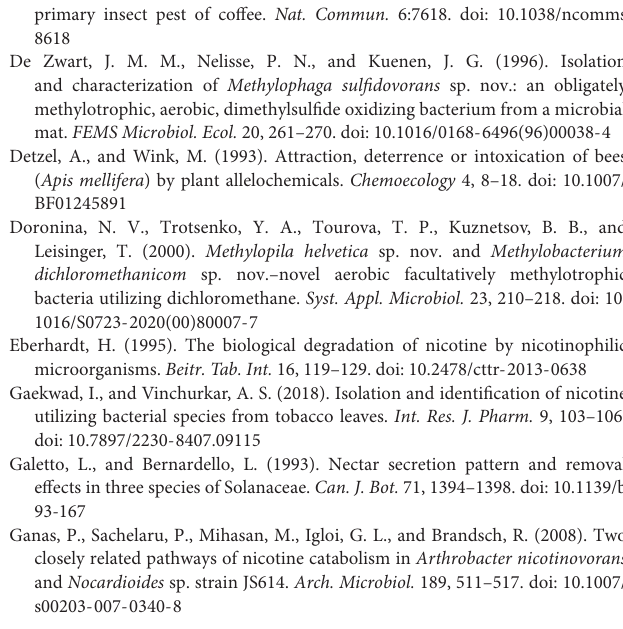
Supplementary Table 5 | Raw data for calculating nicotine degradation efficiency from sunbirds’ excreta, 24 and 72 h after nicotine addition to the food of birds with undisturbed microbiota (control, G2a) and birds with dysbiotic microbiota (G2b). Nicotine concentrations were measured by LC-MS analysis. n = 3 birds for